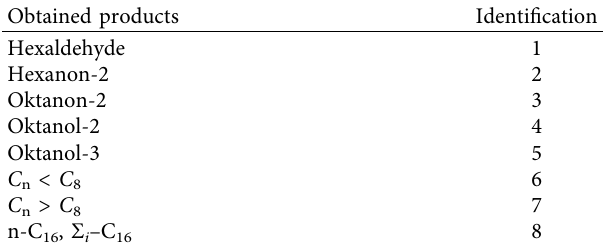
Table 2: Hexane oxidation